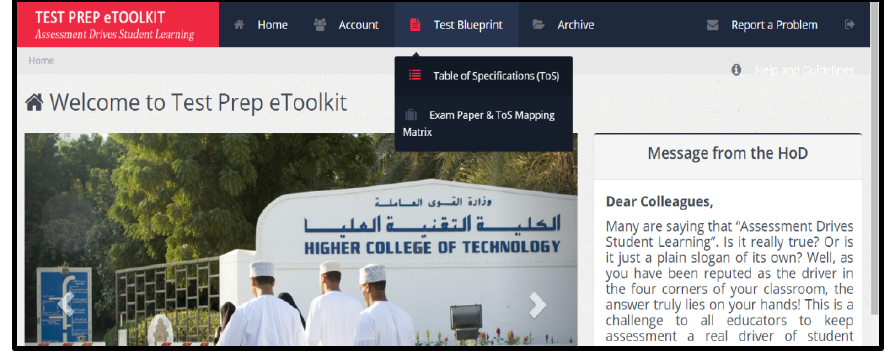
Fig. 5. Web-based Test Blueprint System Home